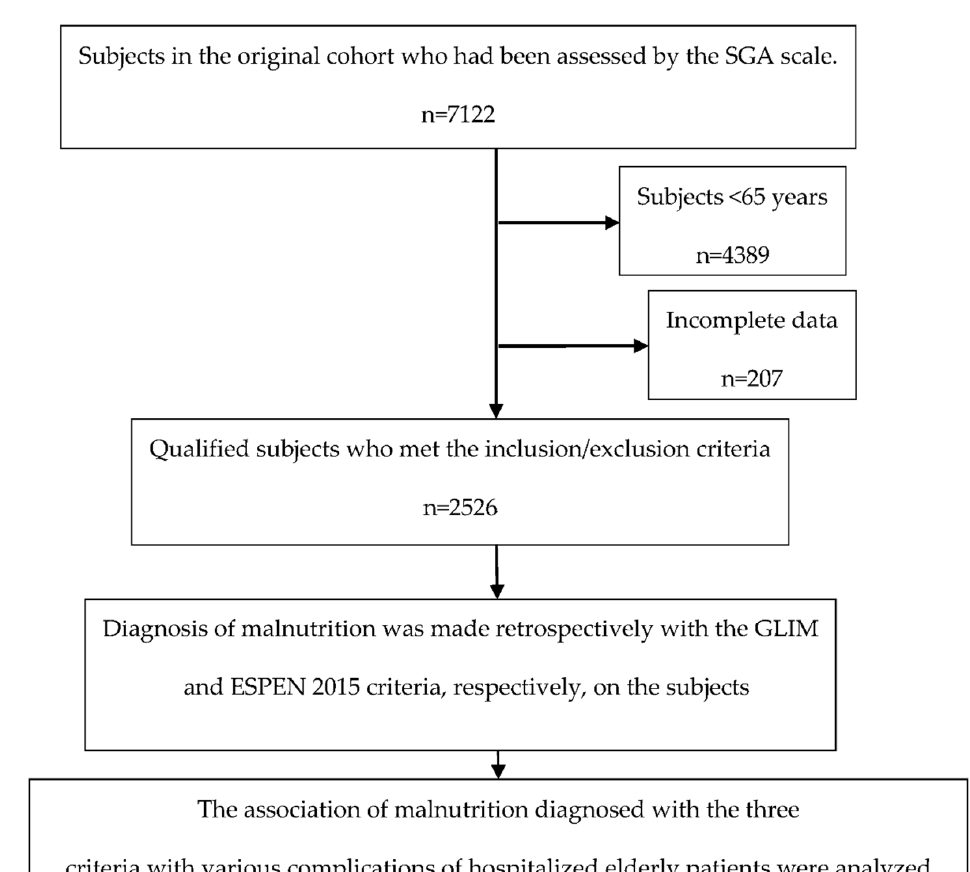
Figure 1. Flow chart of the